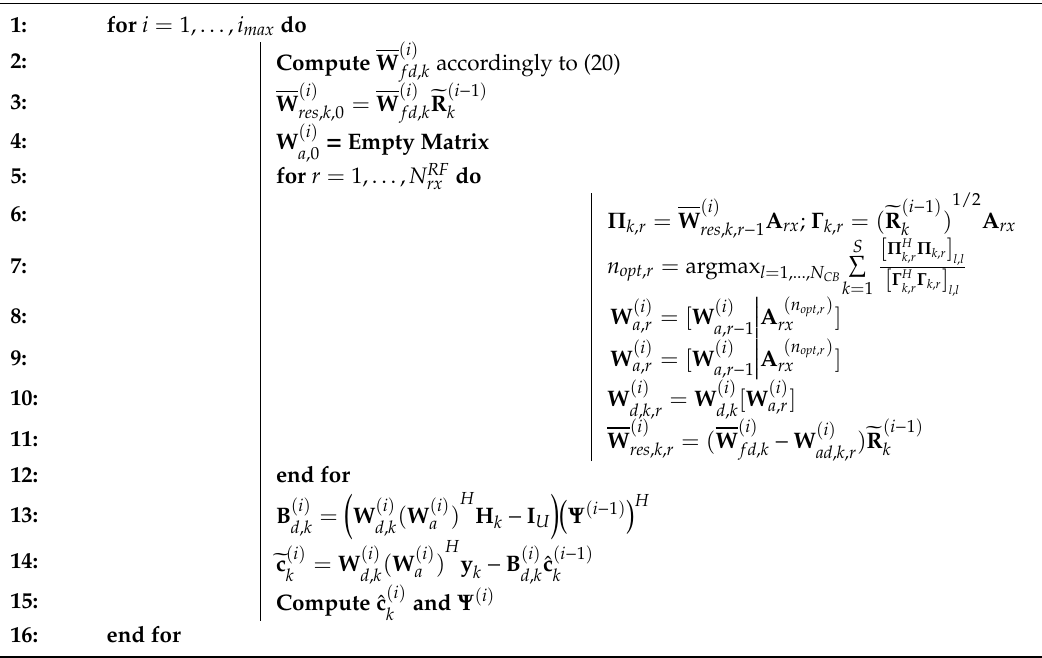
Algorithm 1 The proposed fully iterative hybrid space-frequency multi-user algorithm for broadband mmWave mMIMO